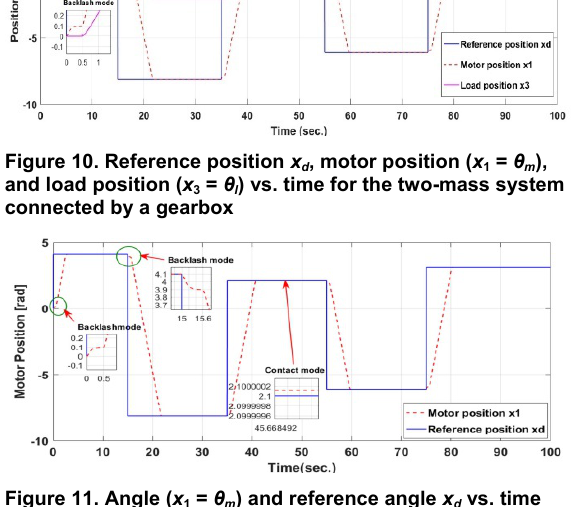
Figure 11. Angle ( x 1 = θ m ) and reference angle x d vs. time for the two-mass system connected by a gearbox